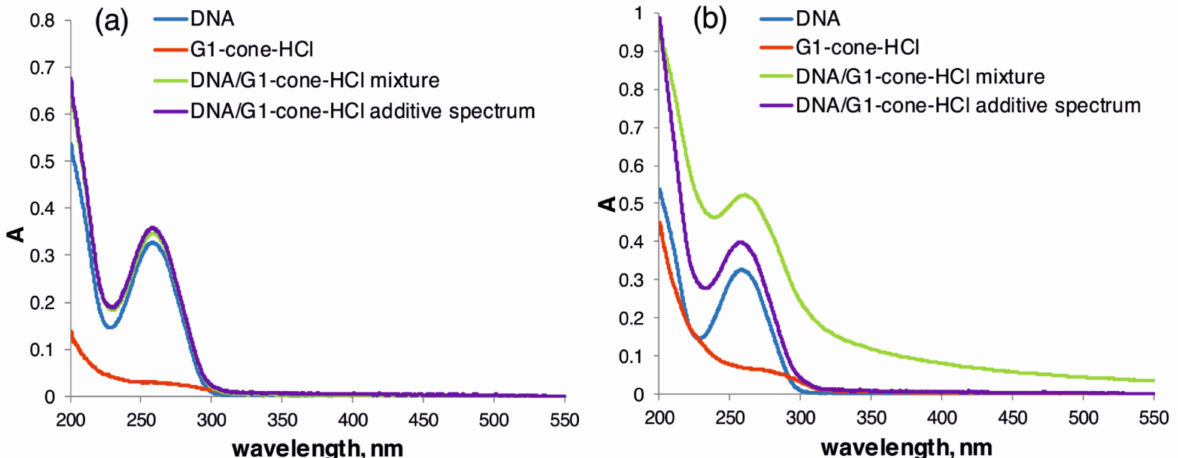
Figure 2. UV-Vis absorption spectra of DNA (1.855 × 10 − 5 M base pairs), G1-cone-HCl and G1-cone-HCl /DNA mixture in 10 mM Tris-HCl buffer (pH = 7.4) for G1-cone-HCl concetrations: ( a ) 8.33 × 10 − 7 M; ( b ) 3.33 × 10 − 5